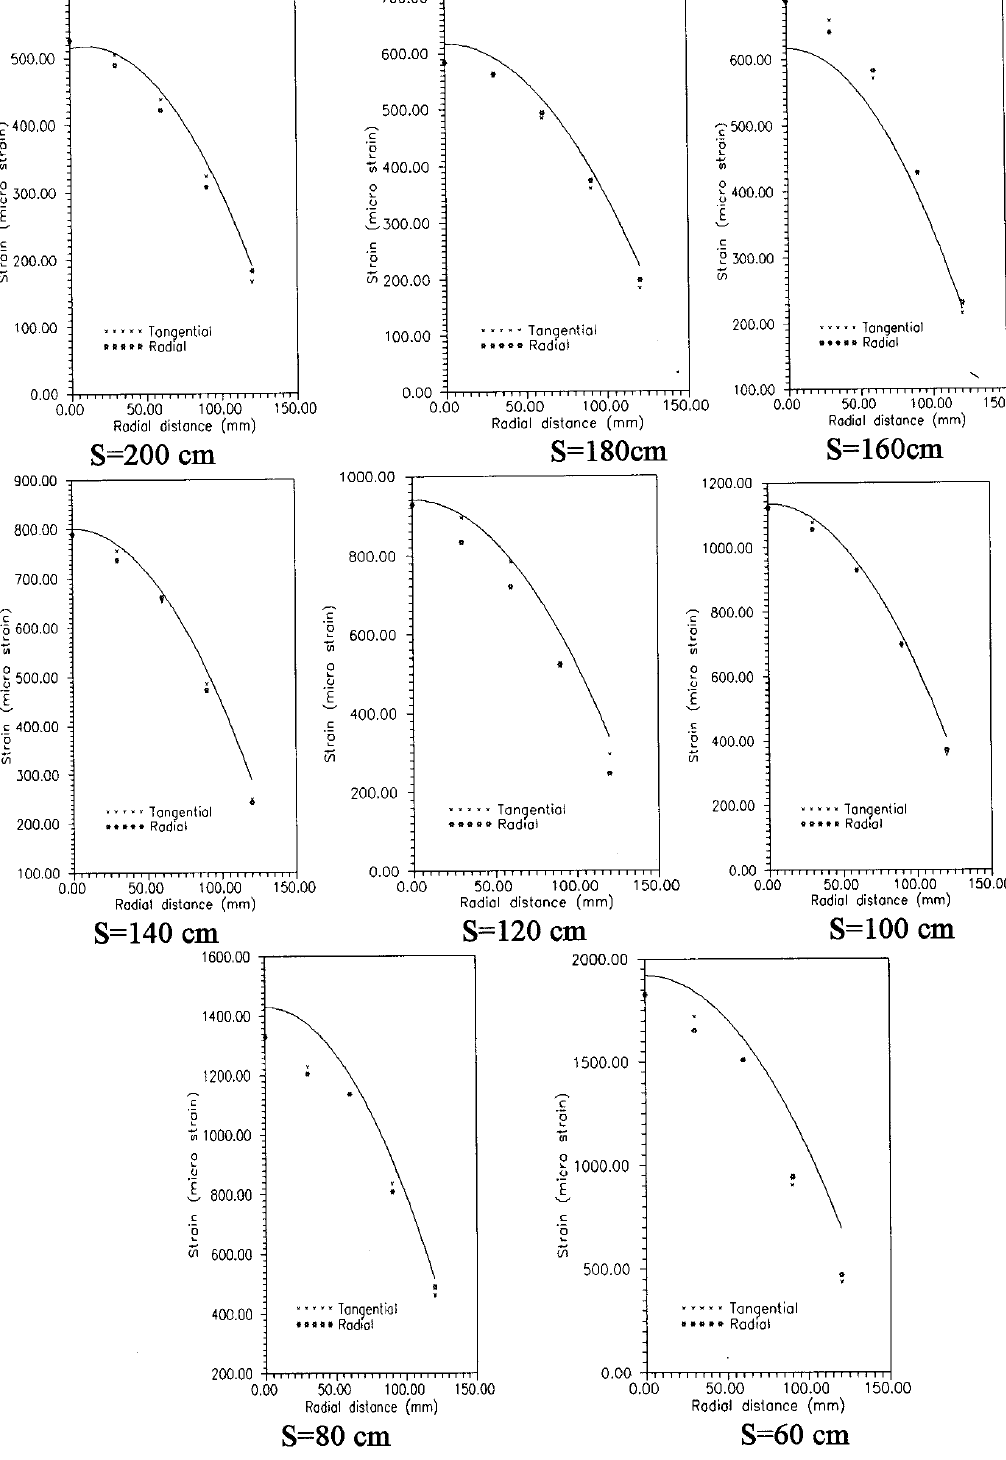
Fig. 7. Variation of tangential and radial strains along the radius of the circular plate. S is stand